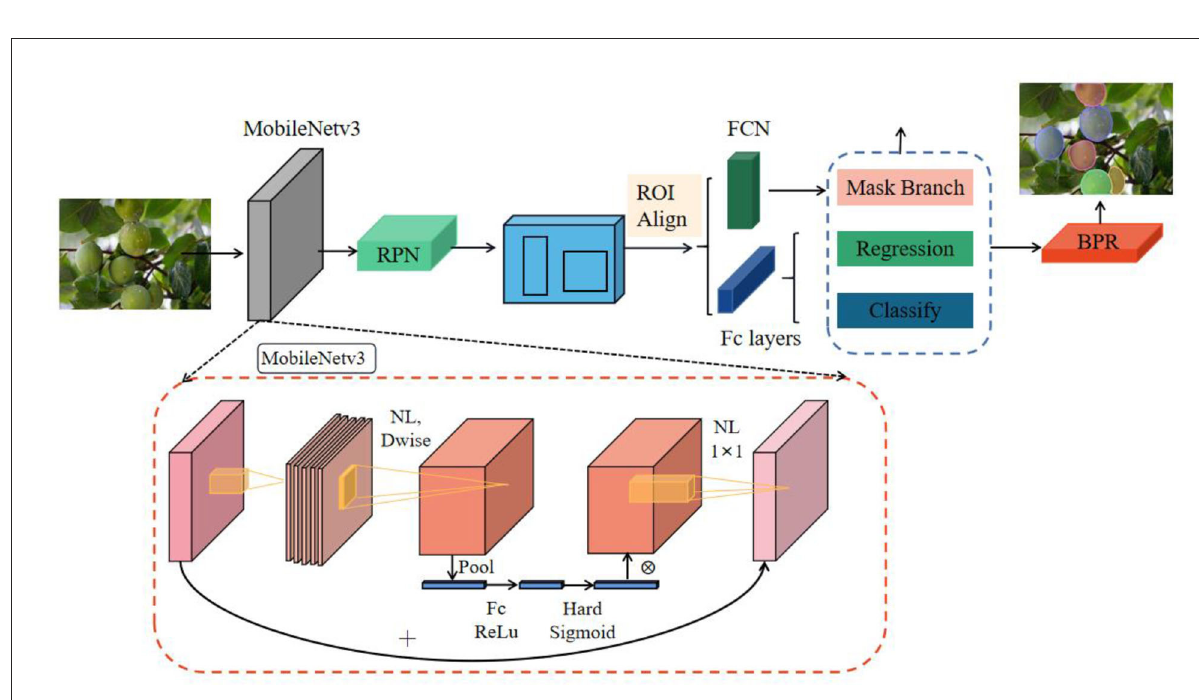
FIGURE2 The overall structure of the optimized mask RCNN. The features of the input image are extracted through MobileNetv3 and FPN structure. The extracted features are used for subsequent classification, regression, and mask operations. Finally, the final segmentation result is obtained by optimizing the rough mask boundary of the boundary through the BPR